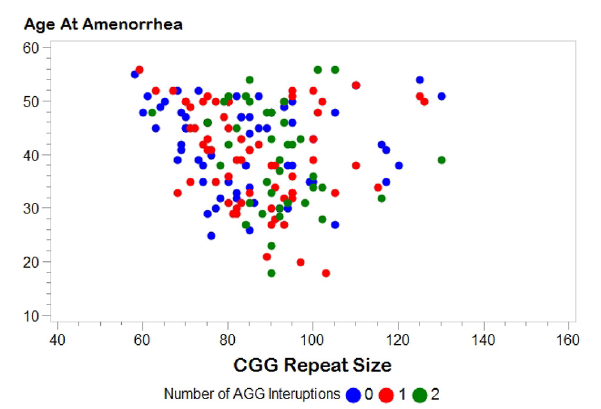
FIGURE 1 | Distribution of age at amenorrhea by FMR1 CGG repeat size. Number of AGG interruptions distinguished by color: blue, 0 AGG interruptions; red, 1 AGG interruption; green, 2 AGG